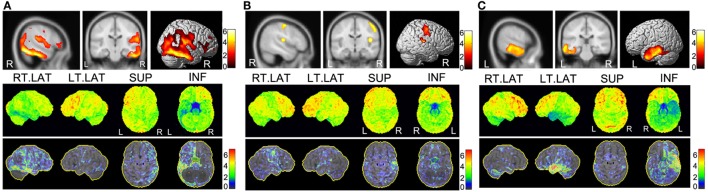
PET imaging results of three cases with non-favorable outcome. In each panel, the upper part is the SPM-PET result (P < 0.001, voxel size 200 corrected), and the lower part is the SD-SSP-PET result with Z-score. (A) Case 8 was diagnosed with encephalitis by postoperative pathological diagnosis. He received right posterior temporal lobe lesion resection with a very poor outcome (Engel IV). Both the SPM-PET and the 3D-SSP-PET result maps reveal a hypometabolic region in right temporal lobe. SPM-PET also shows another hypometabolic area in the right Sylvian fissure extending from the insula. However, the 3D-SSP-PET result map shows a diffuse hypometabolic distribution in the right parietal lobe and frontal lobe. (B) Case 12 underwent right insular lesion resection according to PEZ with a postoperative outcome of Engel III. The SPM-PET result map shows another epileptic locus in the right posterior central gyrus. In addition to a hypometabolic region in the right Sylvian fissure extending from the insula, the posterior central gyrus region shows a high Z-score in the 3D-SSP result. (C) Case 17 underwent left anterior temporal lobectomy with a non-favorable outcome (Engel III). SPM-PET and 3D-SSP-PET result maps show ideal consistency in the localization of a hypometabolic region in the left temporal lobe. Failure of seizure control may have resulted from removal of a region smaller than the real epileptic zone to avoid functional loss.